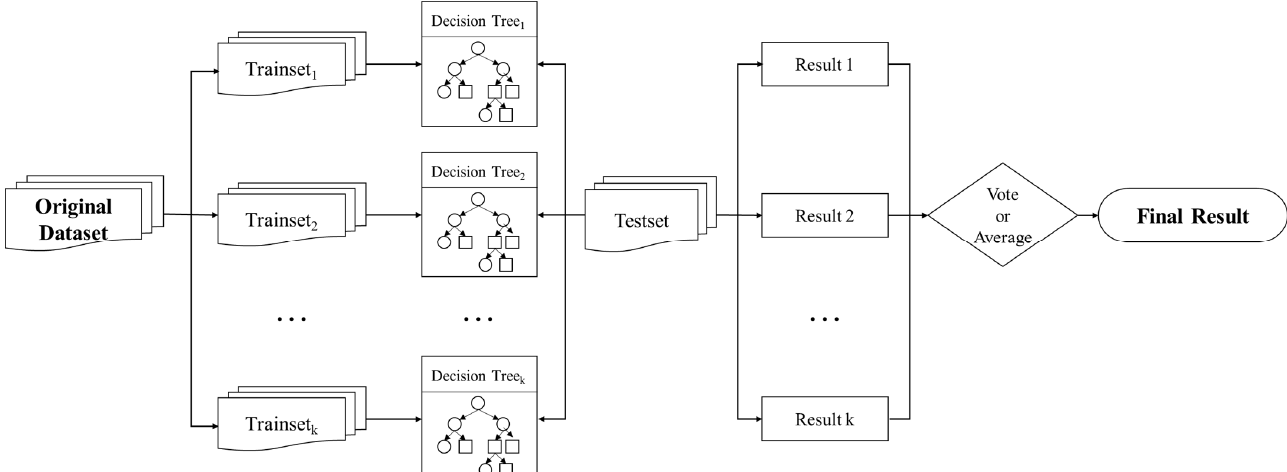
Figure 3. Process of building a RF model.